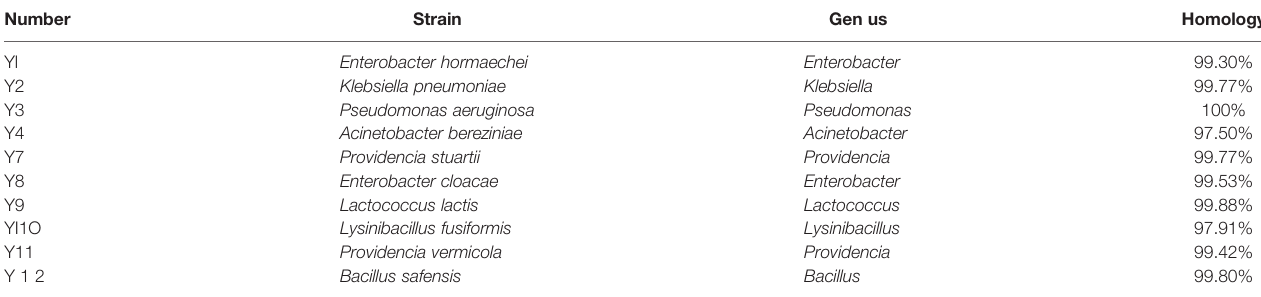
TABLE 1 | Bacteria isolated from the guts of house fl y